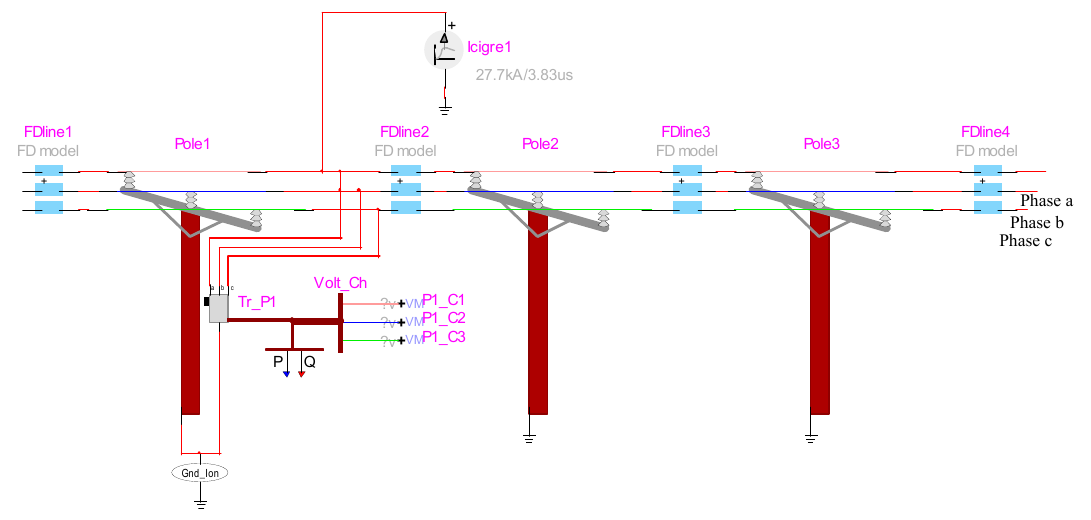
Figure 6. Sample medium voltage network.